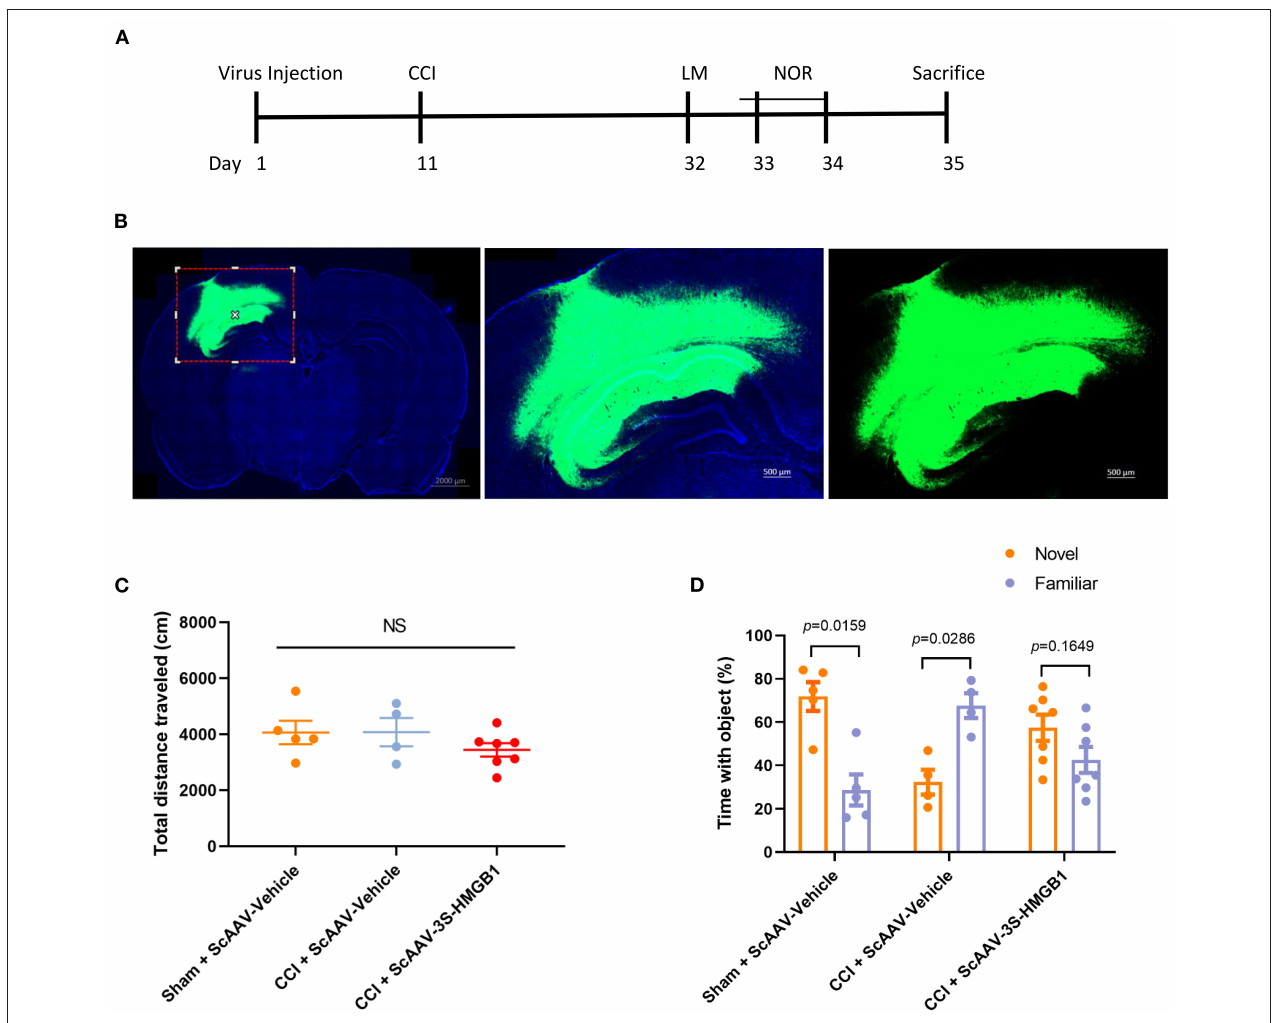
FIGURE 5 | Nonoxid-HMGB1 attenuates learning and memory impairments in CCI rats. (A) The experimental timeline for the neurobehavioral testing. (B) Representative electron microscopy images of brain sections from rats intervened with ScAAV-3S-HMGB1 or ScAAV-Vehicle for 10 days. (C) In the open field test, no differences were observed among three experimental groups. (D) Exploration times and discrimination indices were calculated in NOR test. Mean ± SEM; NS: no